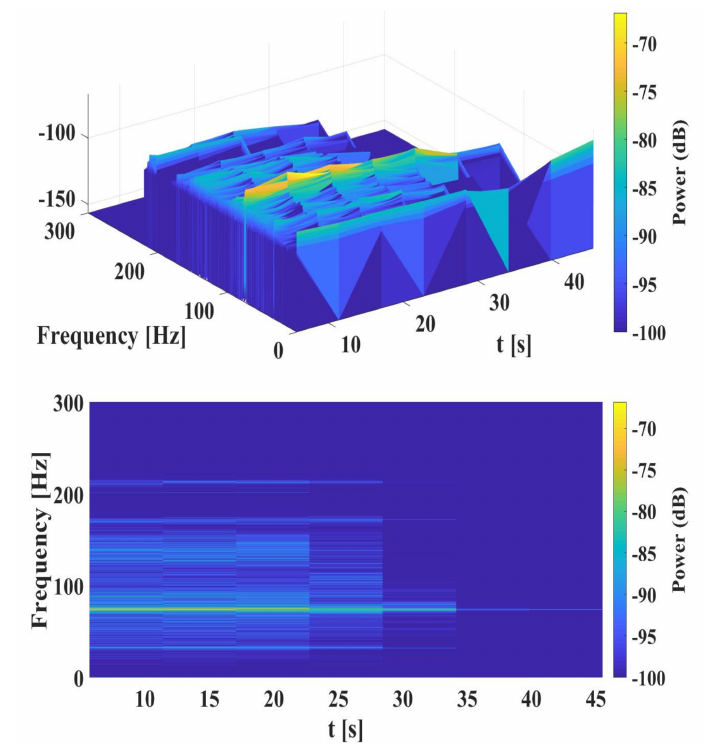
Figure 17. Spectrogram of the velocity